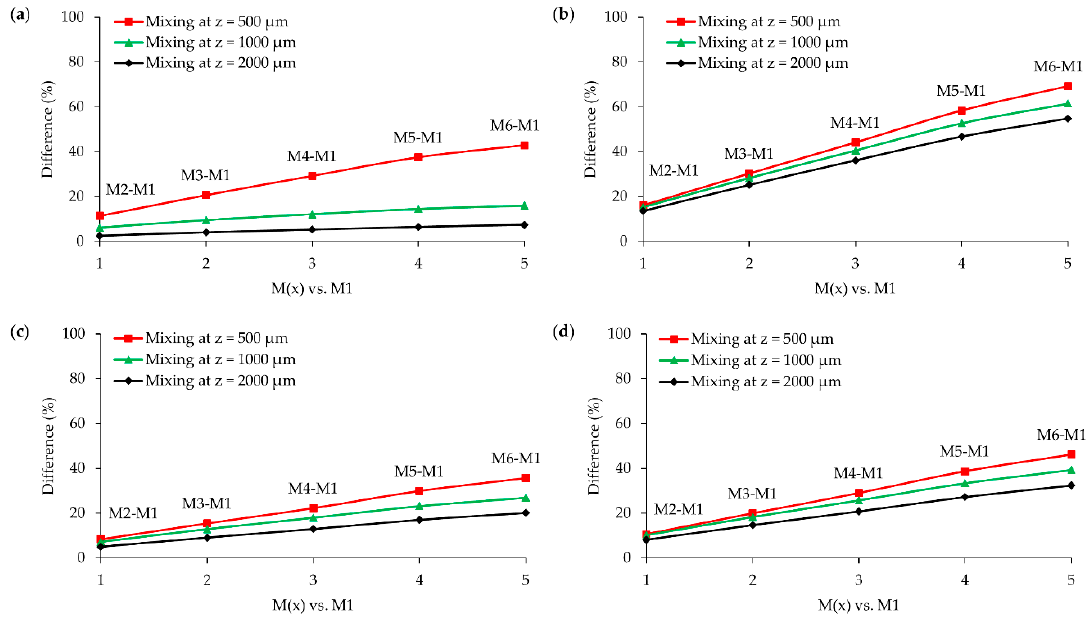
Figure 9. Comparison of meshes (M2, M3, M4, M5, M6) with M1 using Equation (6) at different heights in the mixing channel ( z = 500, 1000, and 2000 μ m): ( a ) and ( c ) four ‐ inlet and two ‐ inlet designs at Re = 240 respectively; ( b ) and ( d ) four ‐ inlet and two ‐ inlet designs at Re = 120 respectively.